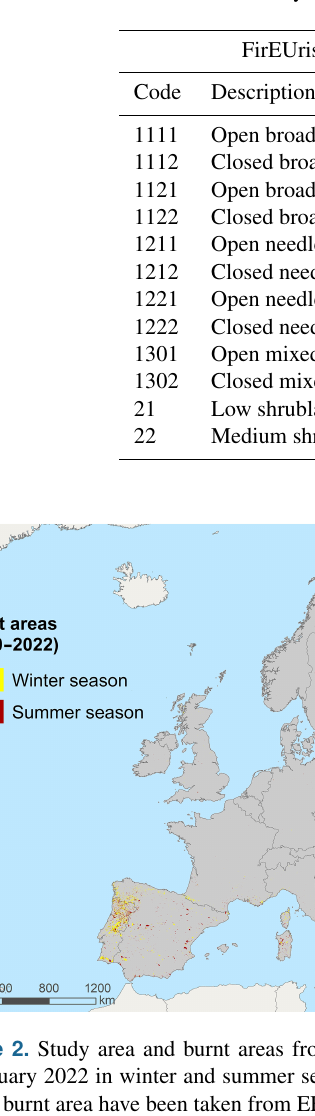
Table 1. A total of 24 first-level FirEUrisk fuel types expected to be mapped at continental scale. See Table A1 in Appendix A for the complete FirEUrisk fuel classification system.